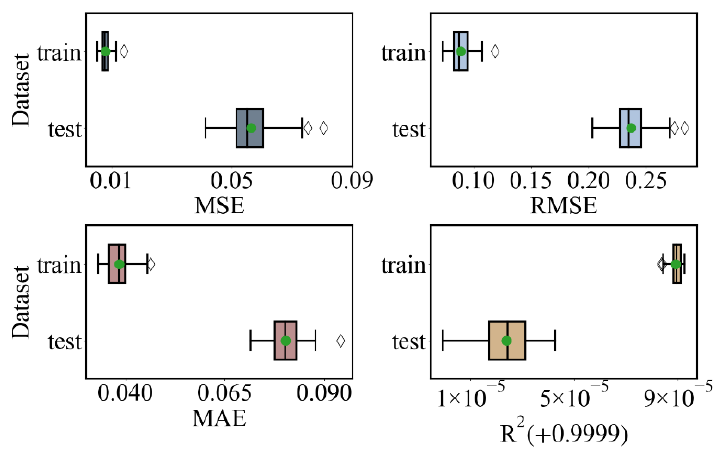
Figure 8. Evaluation results of the optimized XGB.